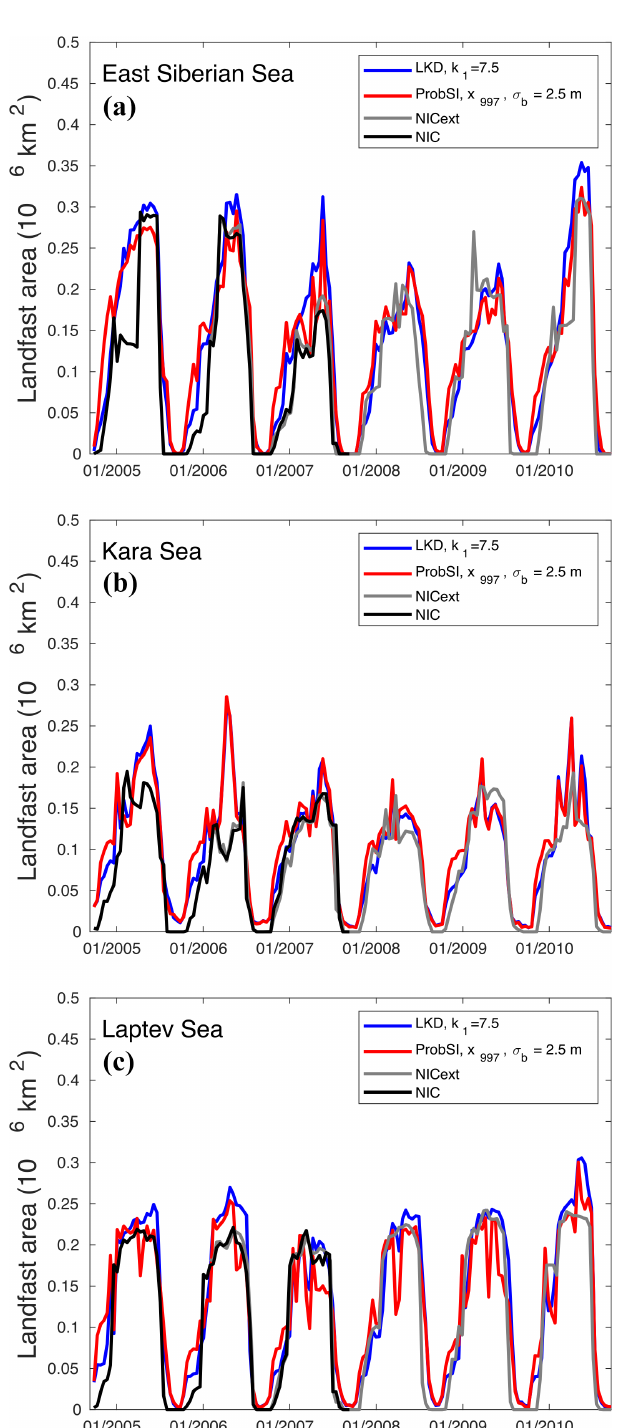
Figure 8. Area of landfast ice in the East Siberian Sea (a) , the Kara Sea (b) and the Laptev Sea (c) as a function of time. The blue curves are for LKD while the red ones are for x k In the three figures, the bold black curve is the area calculated from the NIC data while the grey curve is the extended database produced with the same